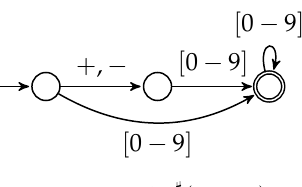
Figure 15. toStr (cid:93) ( (cid:62) Const )